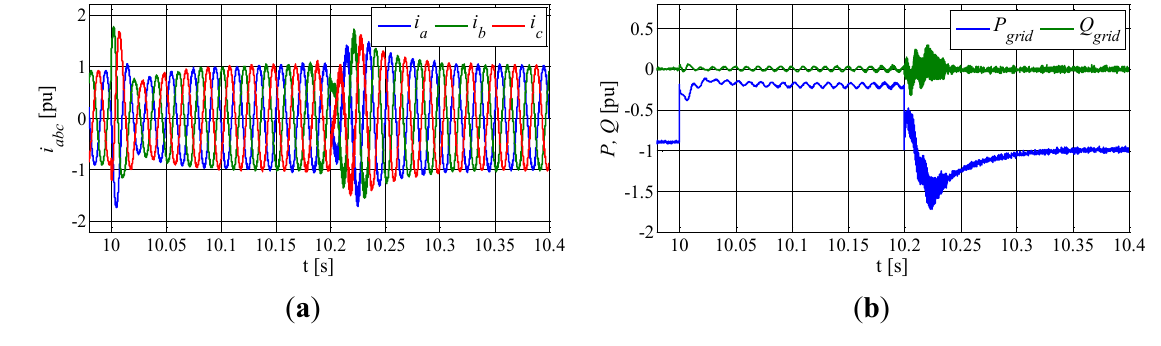
Figure 11. Simulation results under unbalanced grid voltage sag conditions without super-capacitor. ( a ) Grid side converter current; ( b ) Active and reactive power transferred to the grid; ( c ) Generator speed; ( d ) Pitch angle; ( e ) Output power of D-PMSG; and ( f ) EPT low voltage side DC